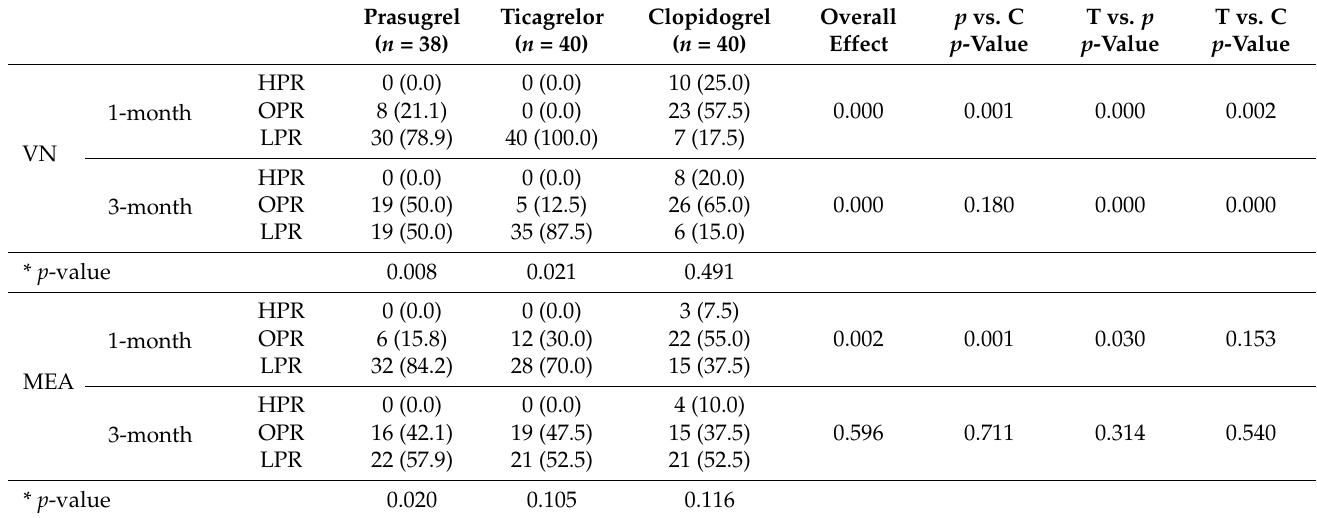
Table 3. Platelet reactivity rate during standard- and reduced-dose periods.